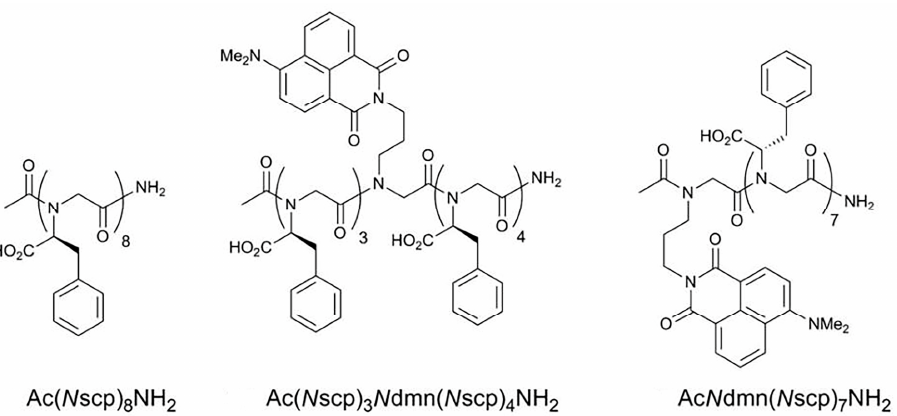
Figure 10. Structures of pH-responsive peptoids prepared. Reprinted with permission from [89]. Copyright 2013, John Wiley and Sons.